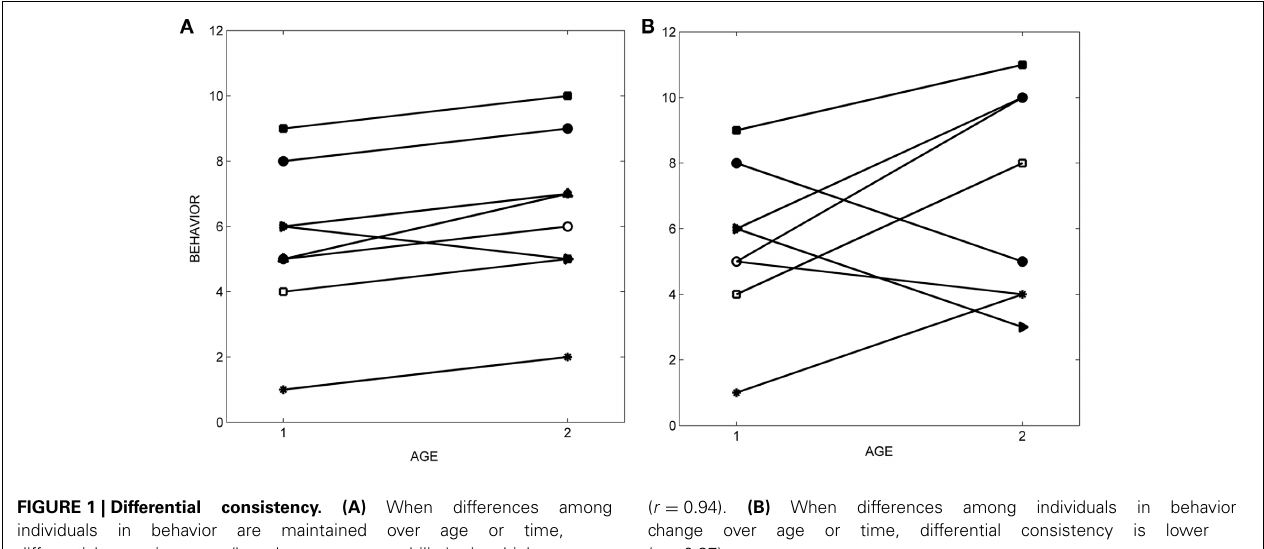
FIGURE 1 | Differential consistency. (A) When differences among individuals in behavior are maintained over age or time, differential consistency (broad-sense repeatability) is high